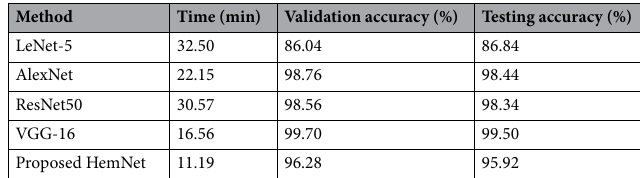
Figure 7. Comparison of Deep Models with Proposed HemNet Network on DIARETDB0 Dataset.